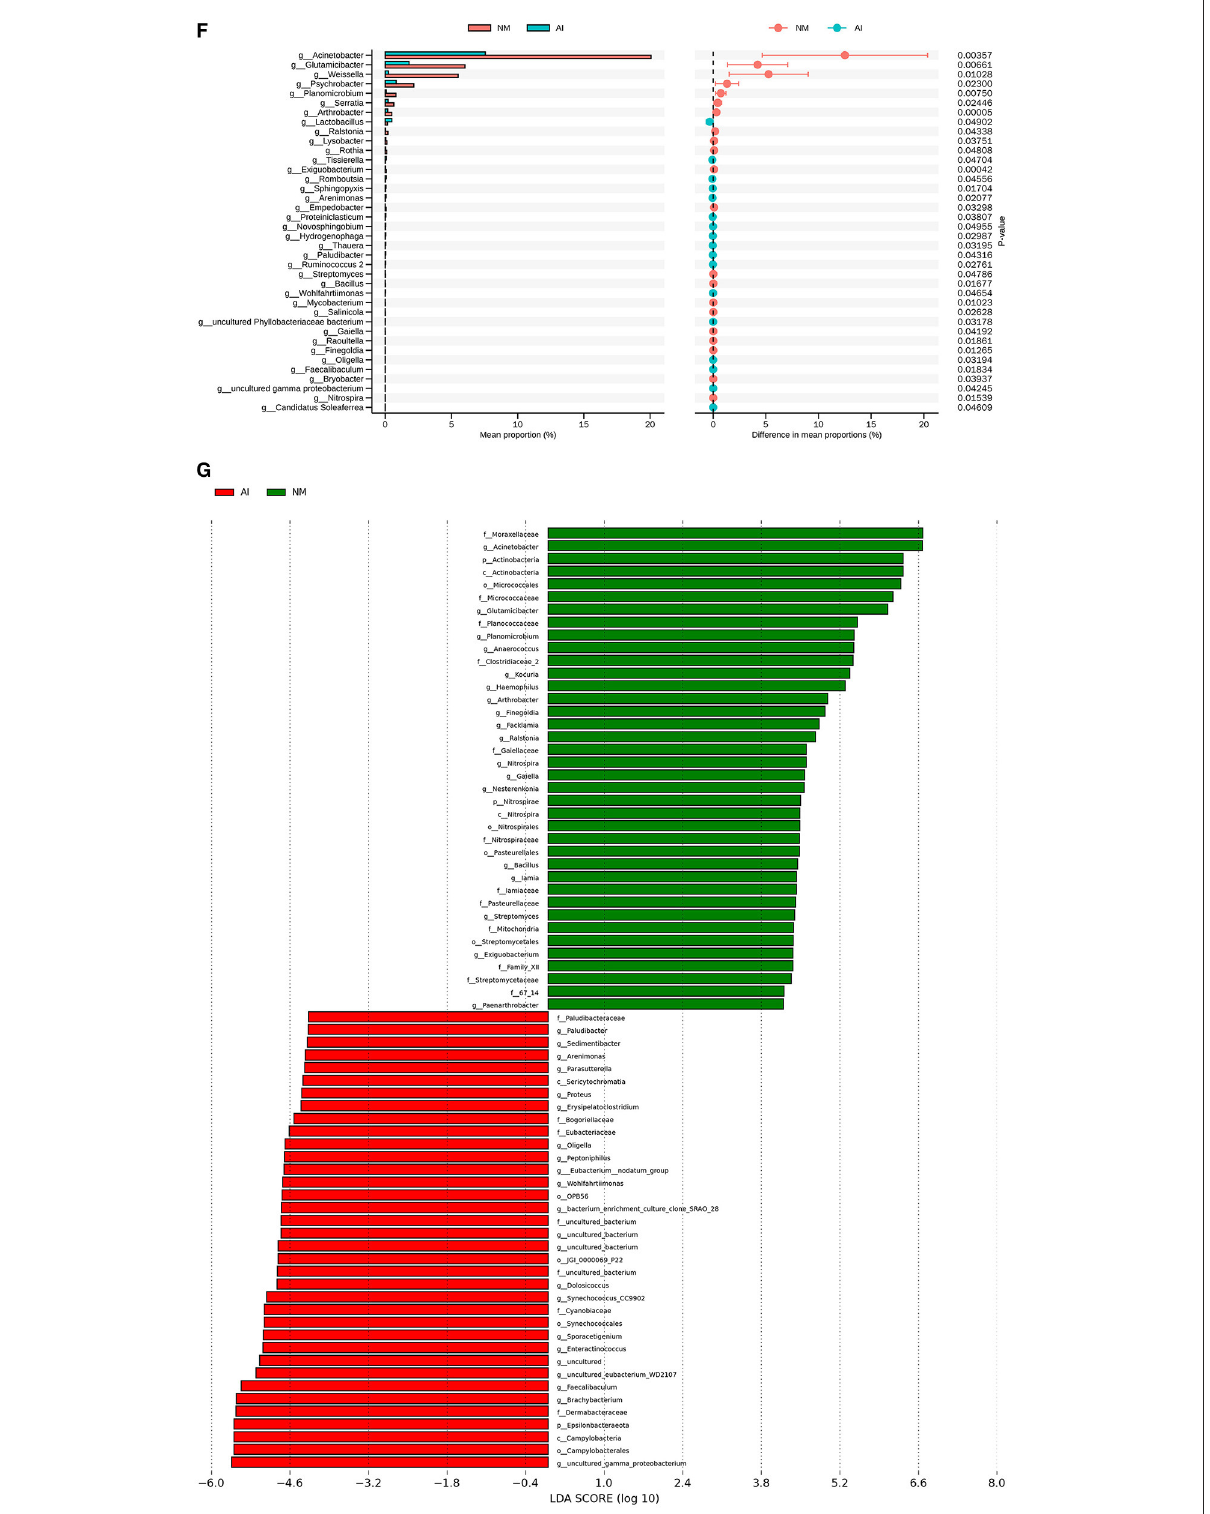
FIGURE3 Urine microbial abundance and beta diversity in giant pandas between NM and AI group. (A) PCoA analysis. The abscissa represents the first principal component, the ordinate represents the second principal component, and the percentage represents the contribution to the